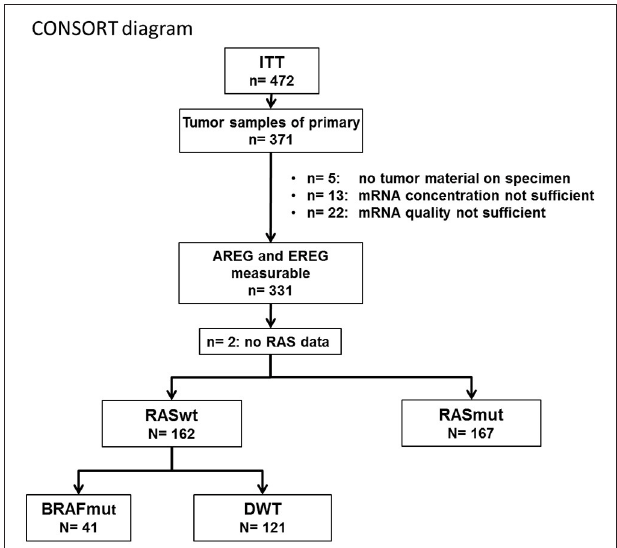
FIGURE 1 | CONSORT